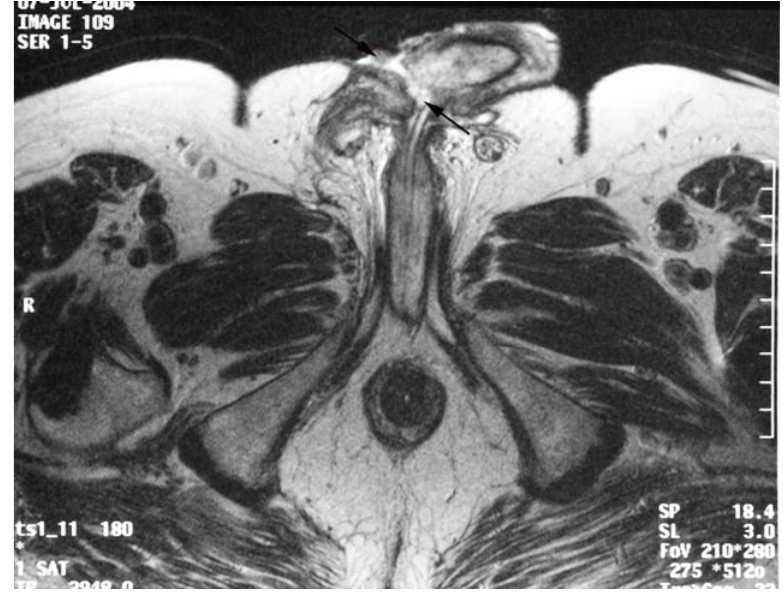
FIGURE 2. MRI pelvis with images centred on the perineum. A skin sinus track (arrows) is evident on the right side of the base of the penis. There was no deep-seated collection